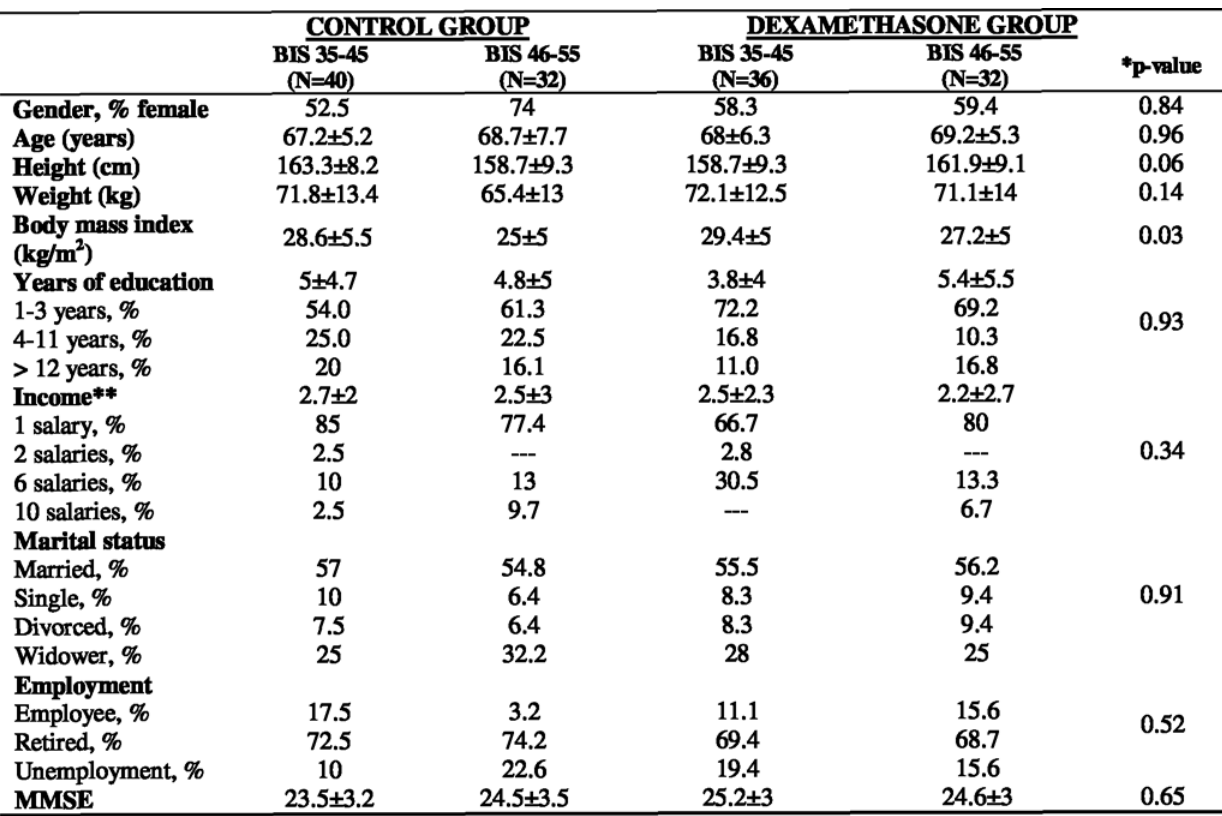
Fig 3. Baseline and demographic data. MMSE: Mini-Mental State Examination; * p- value > 0.05; ** Salary rates equivalent to current Brazilian minimum salary in 2012 ($331.129 USD); *** Data are mean ± SD or per cent.